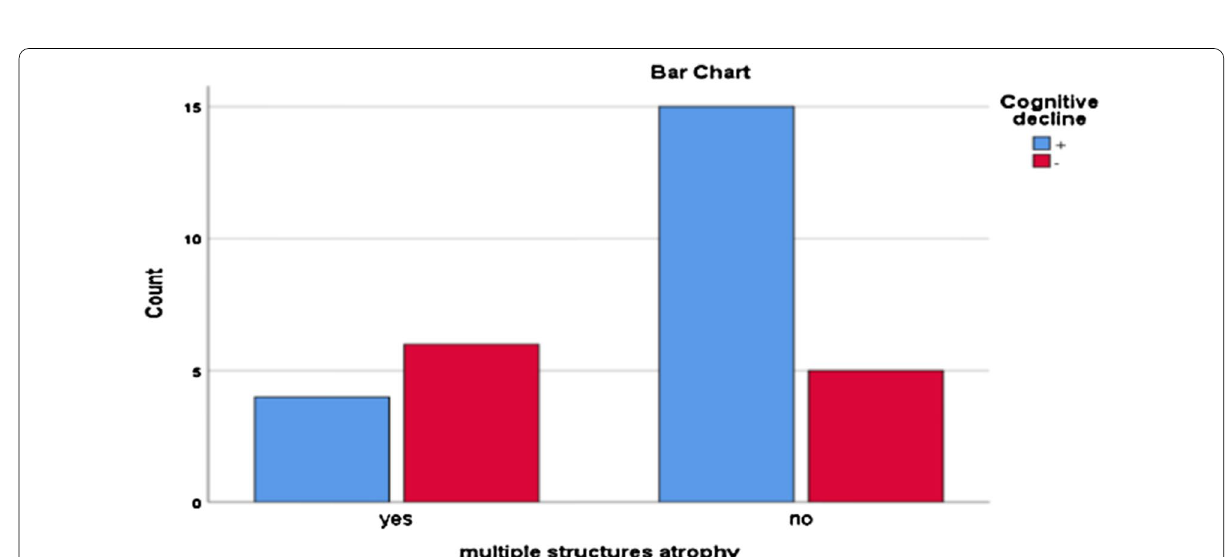
Fig. 18 Diagrammatic representation of number of patients with cognitive decline in patients with and without multiple structures